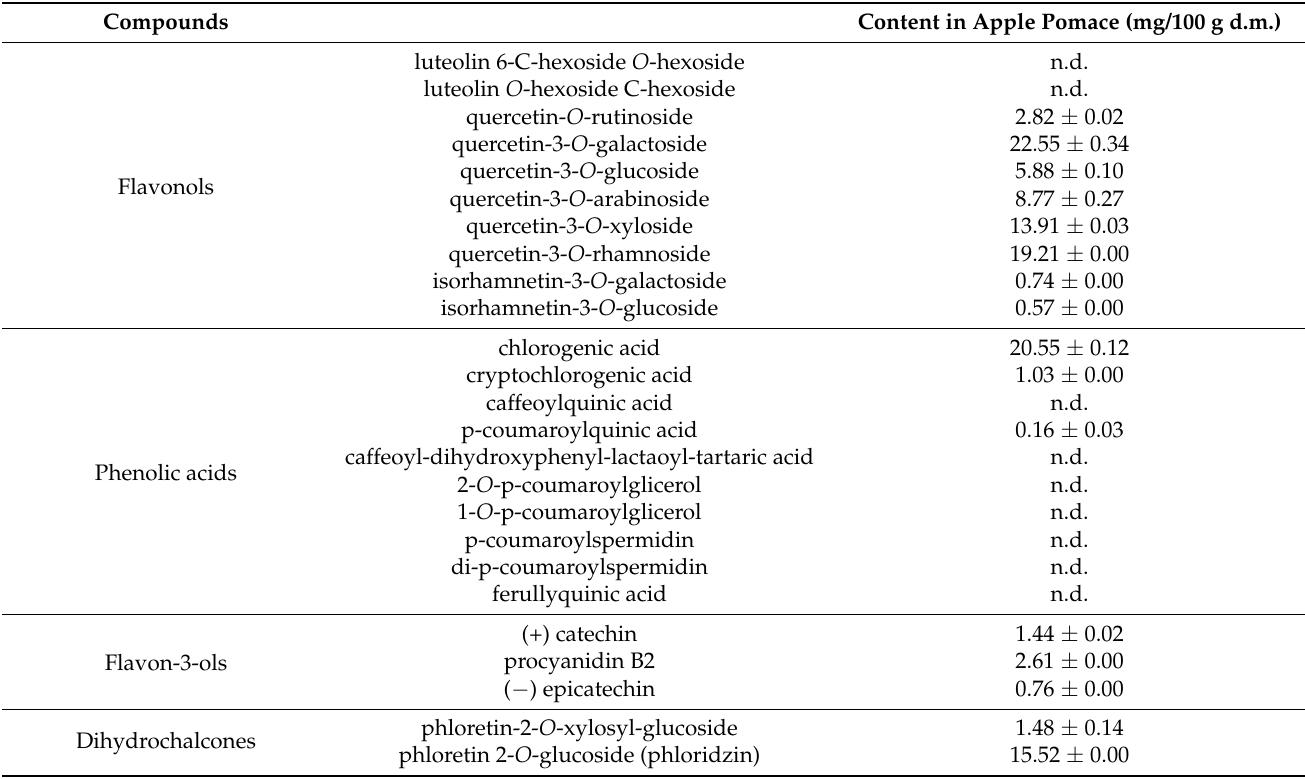
Table 2. Quality and quantity of phenolic compounds in the apple pomace.